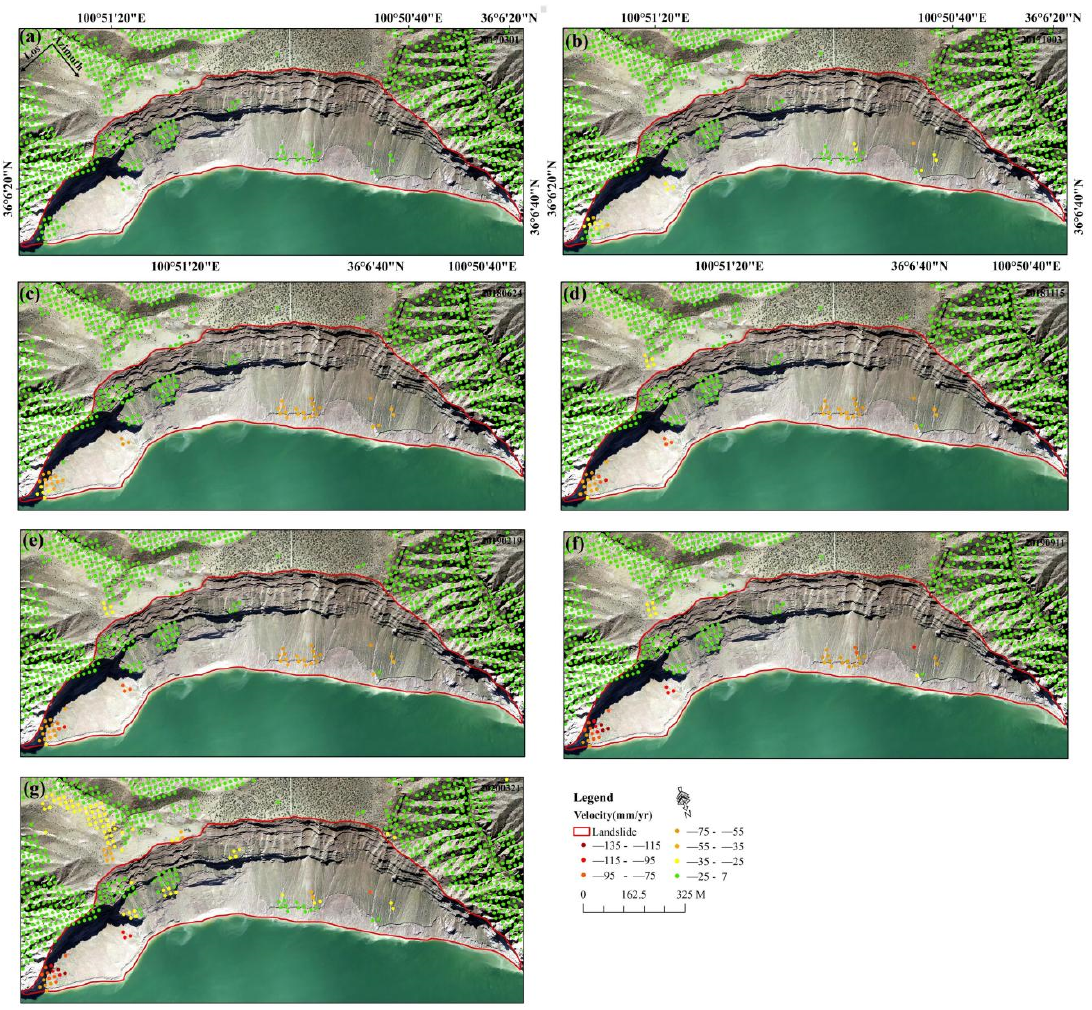
Figure 10. Spatial deformation characteristics of the Chana landslide. ( a ) Cumulative displacement of Chana landslide on 1 March 2017, ( b ) Cumulative displacement of Chana landslide on 3